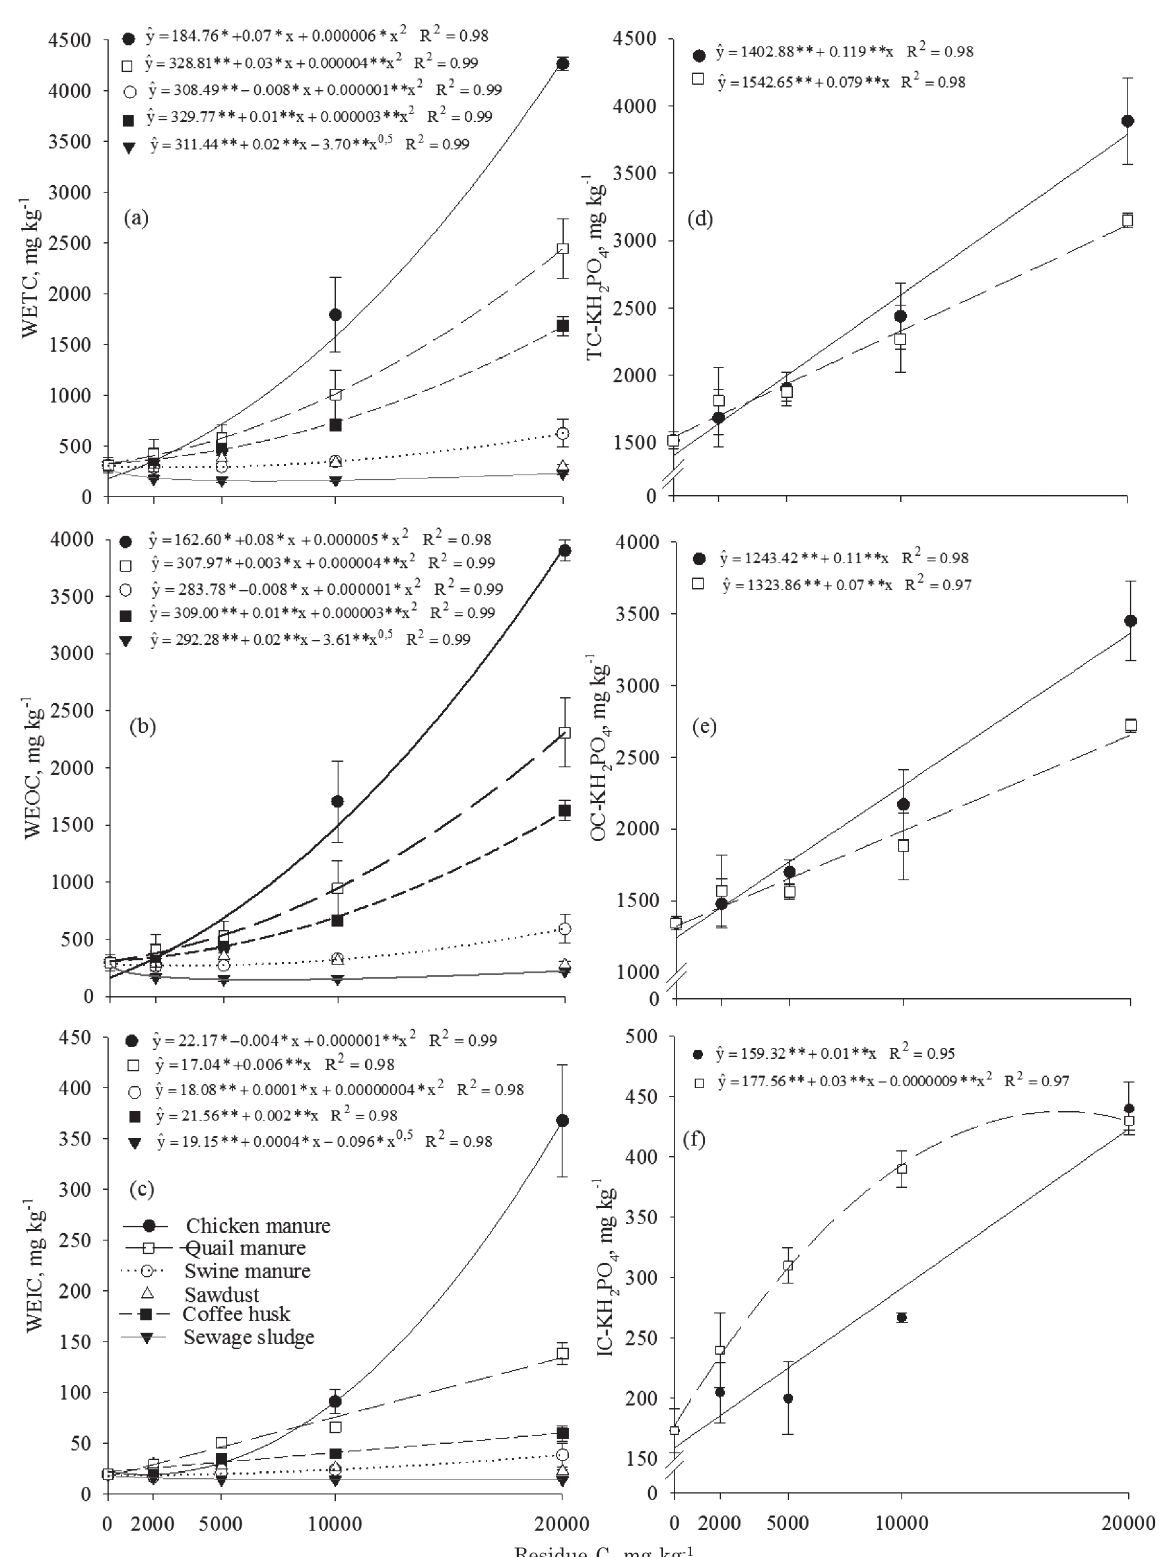
Residue C, mg kg